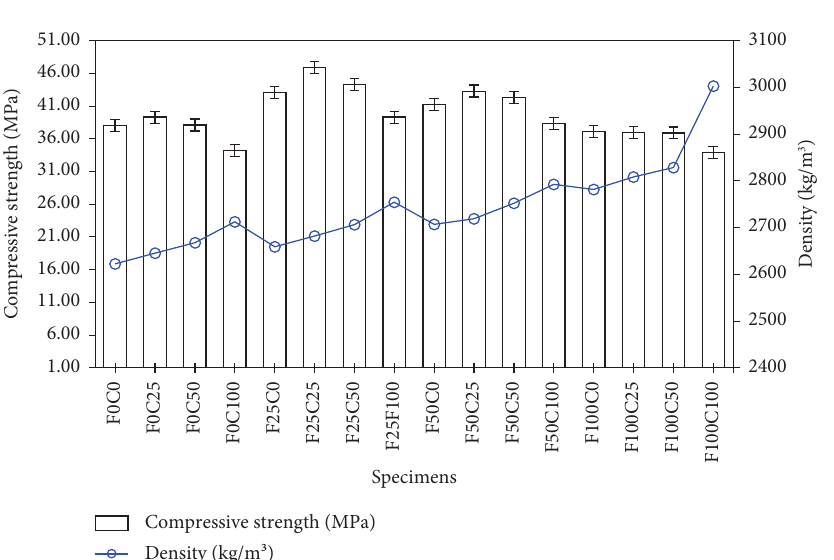
Figure 7: Compressive strength and density of concrete specimens containing diferent amount of serpentine aggregates.